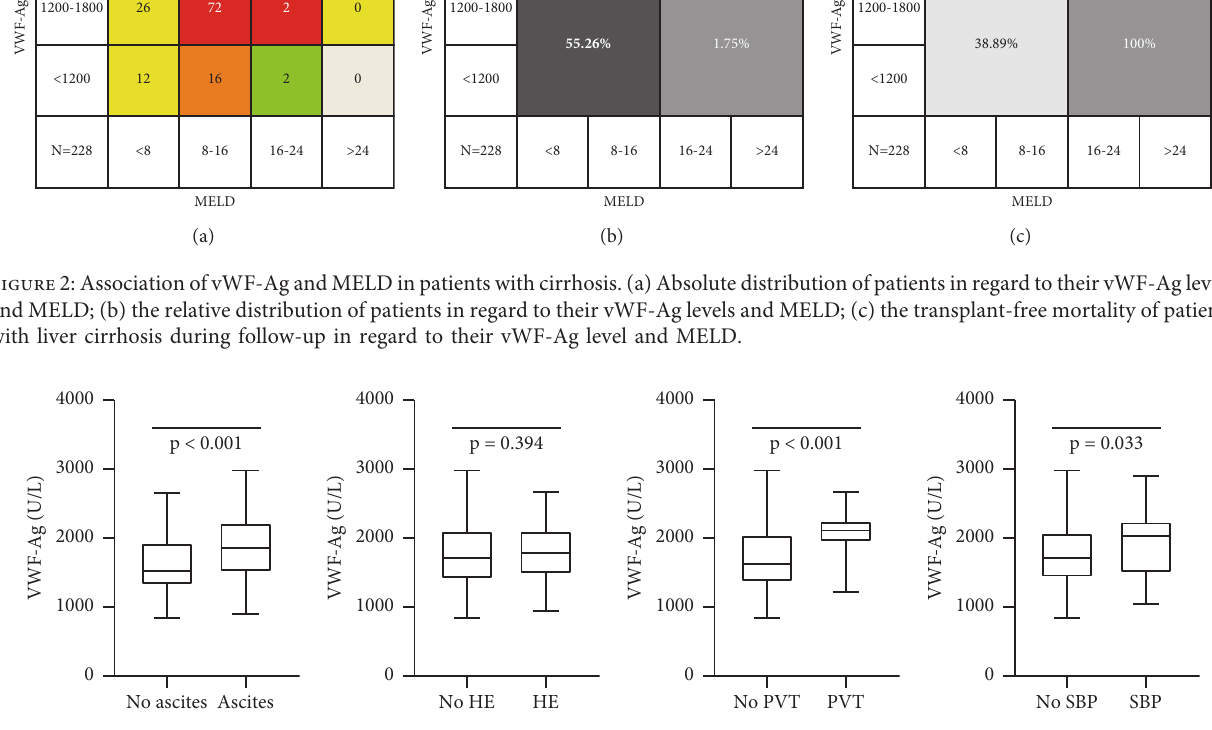
Figure 3: Comparing vWF-Ag levels between patients with different complications. (a)vWF-Ag levels between patients with or without ascites; (b) vWF-Ag levels between patients with or without hepatic encephalopathy; (c) vWF-Ag levels between patients with or without portal vein thrombosis (PVT); (d) vWF-Ag levels between patients with or without spontaneous bacterial peritonitis